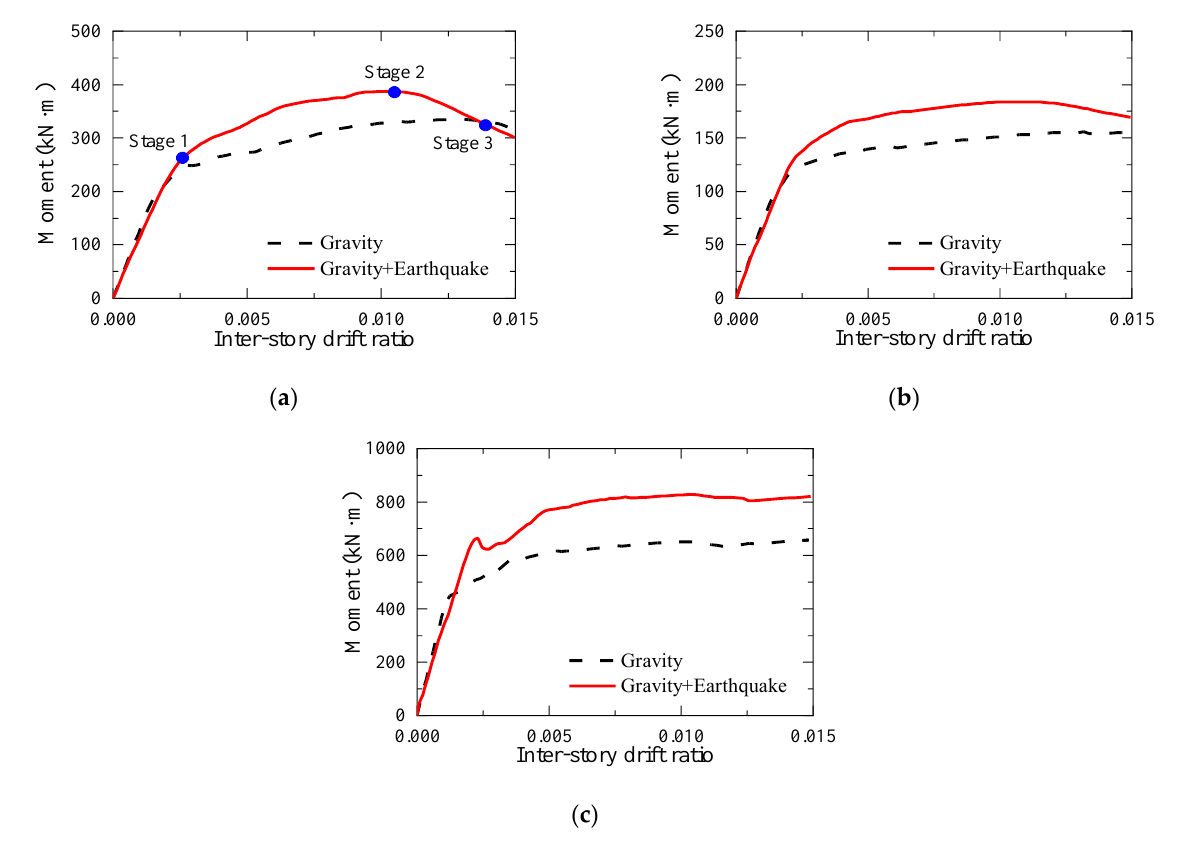
Figure 12. Bending moment-curvature curves of columns under different compression load: ( a ) Original station; ( b ) Original tunnel; ( c ) New station.